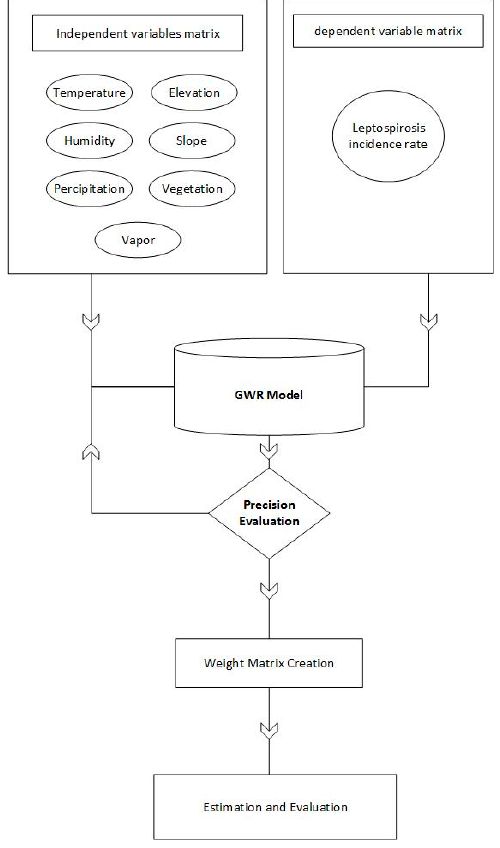
Figure 3. Structure of study.